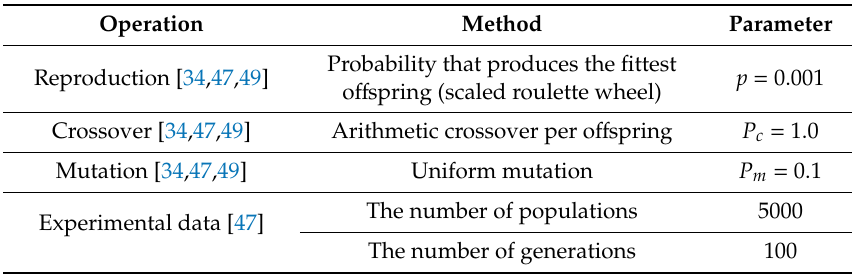
Table 1. Parameters of the genetic algorithm (GA).